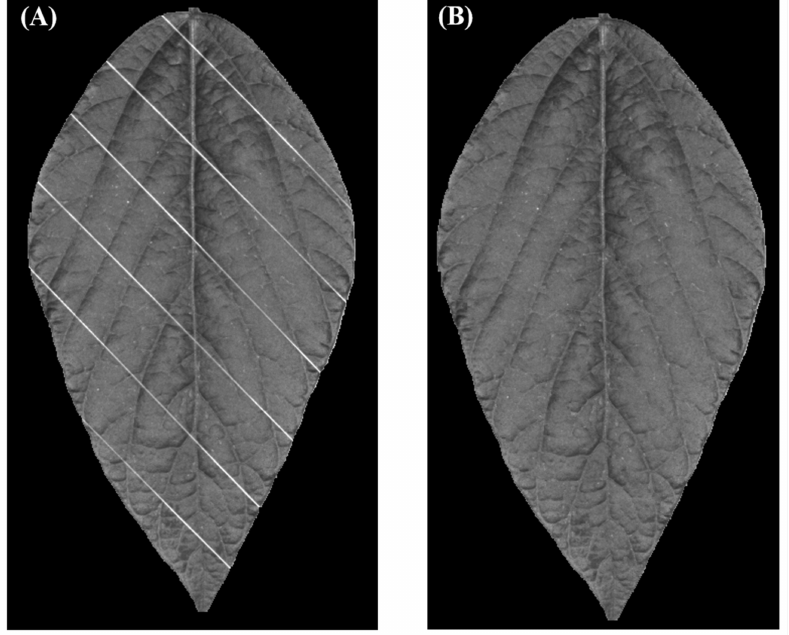
Figure 5. Image inpainting results. ( A ) Image before inpainting. ( B ) Image after